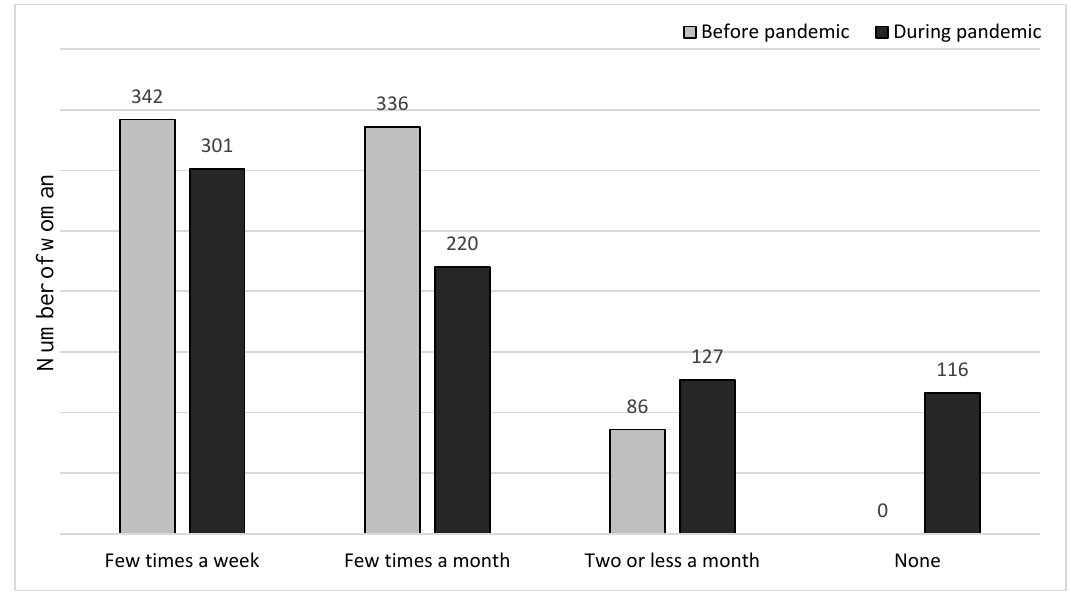
Figure 1. Frequency of sexual intercourse before and after pandemic.